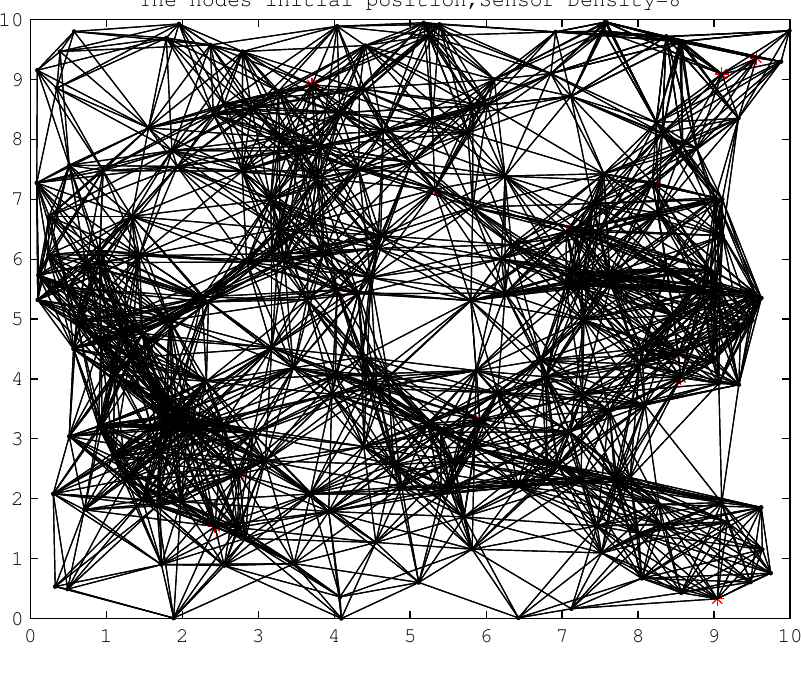
Figure 11. Initial node deployment in isotropic